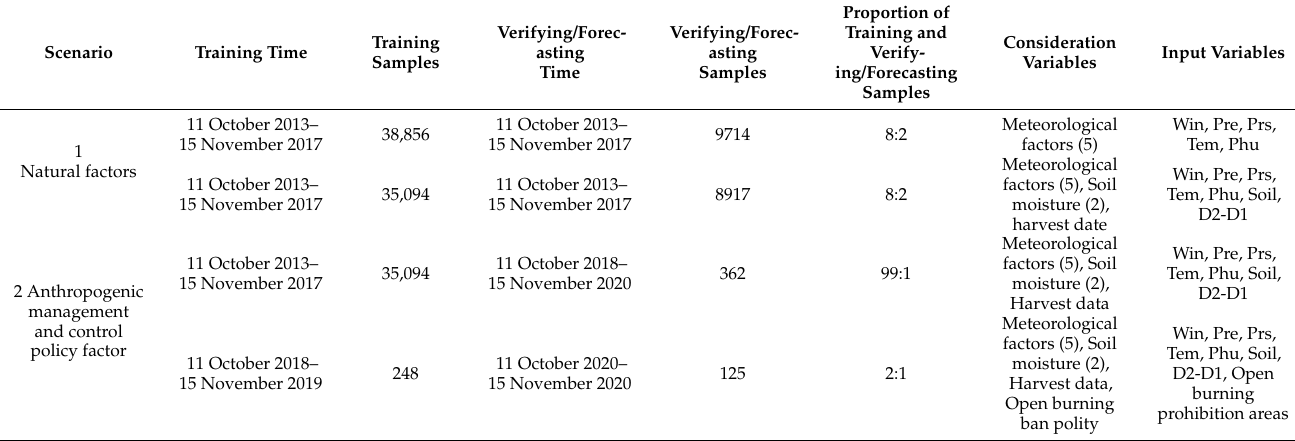
Table 1. Information about the training and verification of forecasting samples in the two scenarios of this study (WIN: average daily wind speed; PRE: 24 h cumulative rainfall; TEM: average daily air temperature; PRS: average daily air pressure; PHU: average daily relative humidity; SOIL: daily soil moisture content; D2-D1: change in soil moisture content within a 24 h